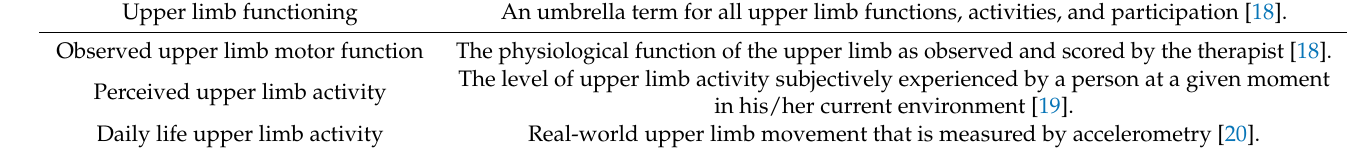
Table 1. Definitions for key terms.